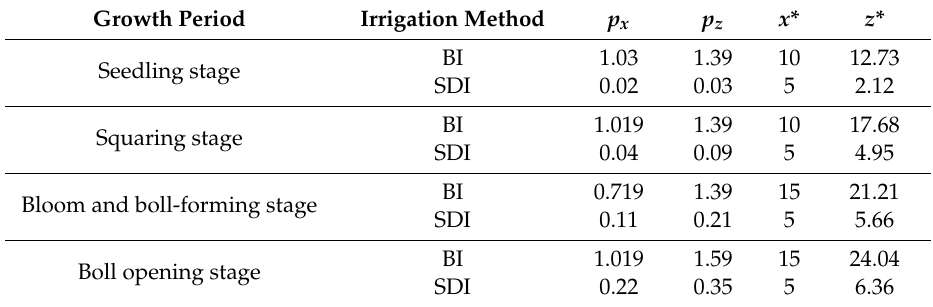
Table 7. Parameters of the two-dimensional model of the root length density (RLD) of transplanted cotton.